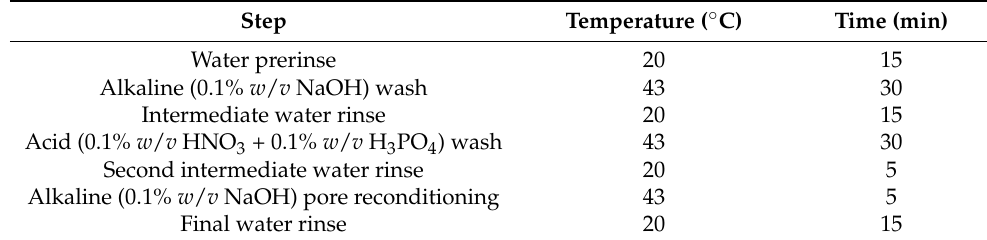
Table 1. Operating conditions of the CIP process.